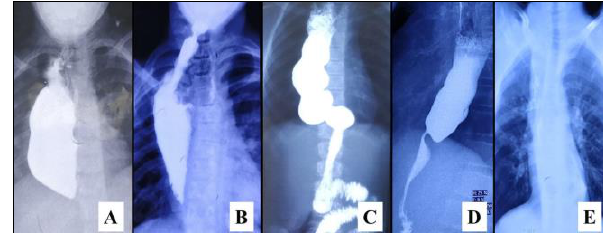
Figure 2: Oral contrast study (done during the study period) showing a healthy conduit in all the child.(A) Mild hold-up of contrast in pulled up stomach of 12-year child.(B) A normal caliber anastomosis between cervical esophagus and pulled up stomach is located in lower neck of 16-year child with free passage of contrast across it.(C) The elongated transposed stomach in the thorax in 10-year old child with normal passage of contrast.(D) 19-year old child with slow transit of contrast, however with complete contrast clearance (E) from transposed stomach